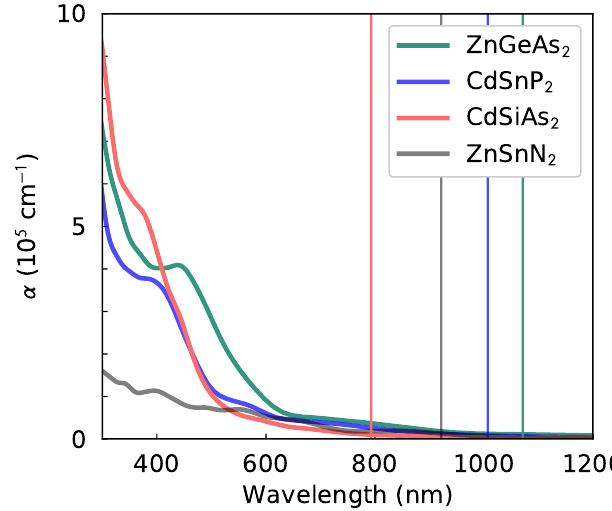
Figure 4. The calculated absorption coefficient of selected materials. The vertical lines represent the band gap energies. (Color